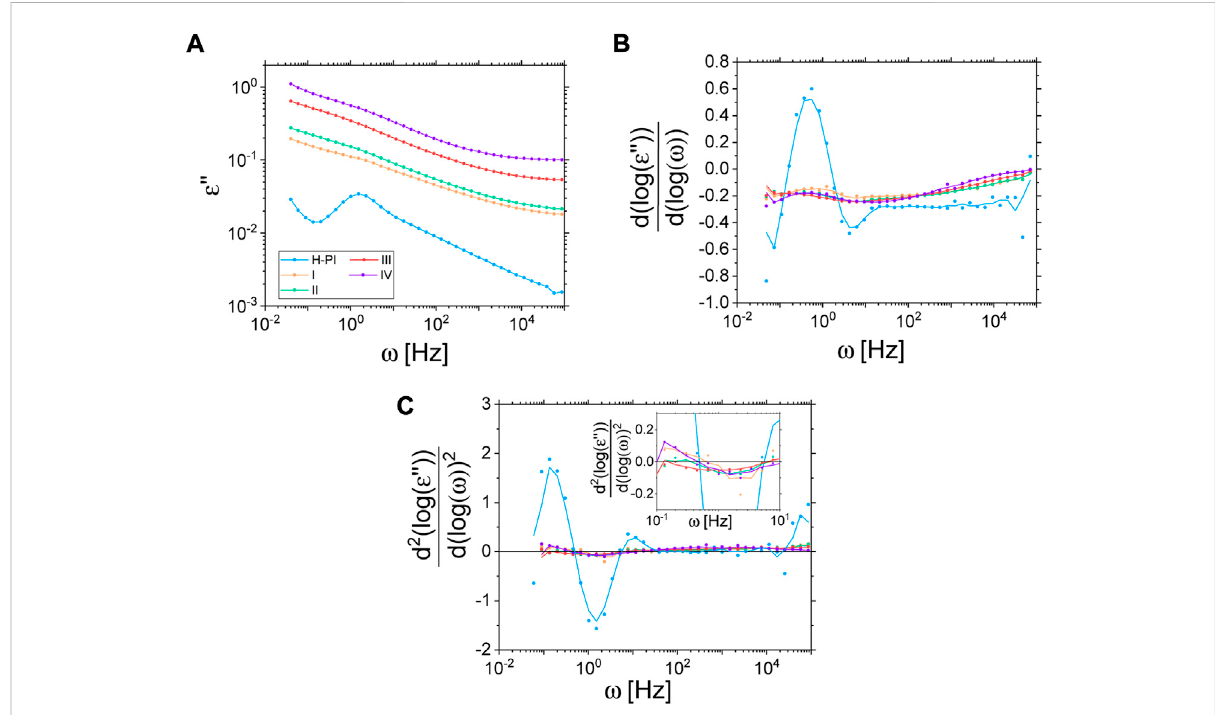
FIGURE 12 Imaginarypartofthepermittivity (A) andits fi rst (B) andsecondderivative (C) forvarioussamplesat313K(solidlinesforderivativesareamoving average over 3 data points to reduce noise as a guide for the eye). Insert in Cshows a zoom in the region of